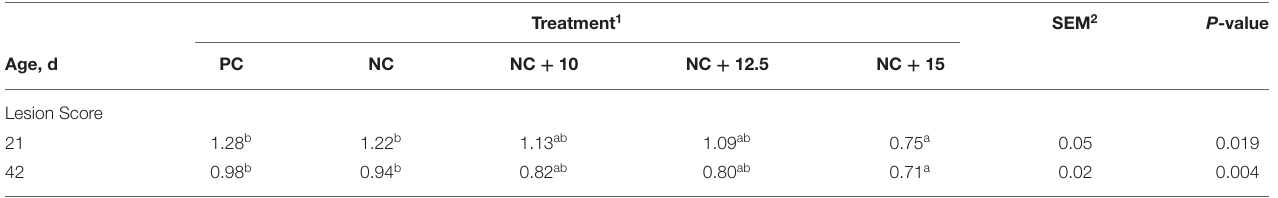
TABLE 4 | Least-squares means for intestinal lesion scores of broilers raised to 42 d. Treatment 1 SEM 2